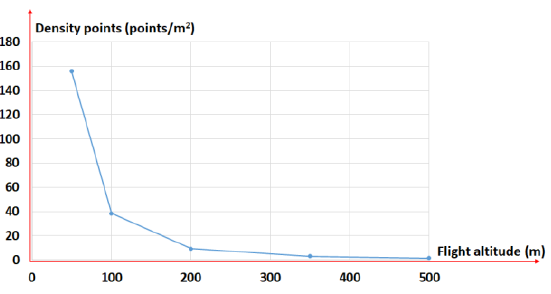
Figure 7: point cloud density according to flight altitude.